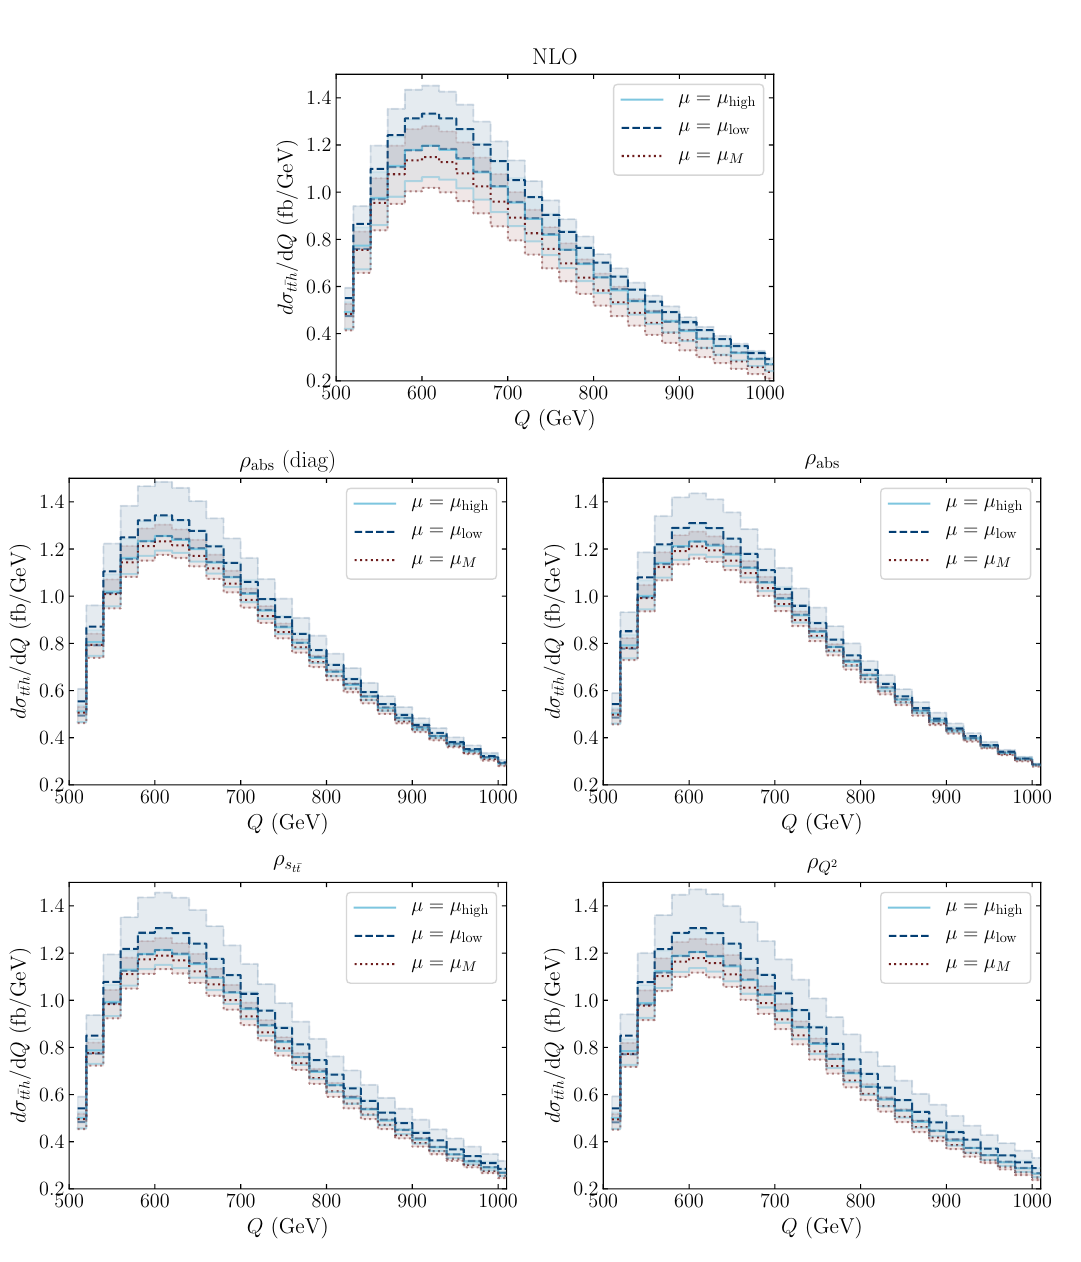
Figure 3 . Invariant-mass distributions for the scale choices µ = µ high (light-blue solid), µ = µ low (dark-blue dashed), and µ = µ = Q (red dotted). Shown are the NLO result (upper panel), and M the matched resummed result using ρ with/without approximating the soft-anomalous dimension abs matrix (middle left/right), ρ (lower left) and ρ (lower right). The colored bands indicate the s t ¯ t Q 2 scale uncertainty within each scale choice as obtained by varying µ between µ 2 and 2 µ , with ref / ref µ ref the reference factorization/renormalization